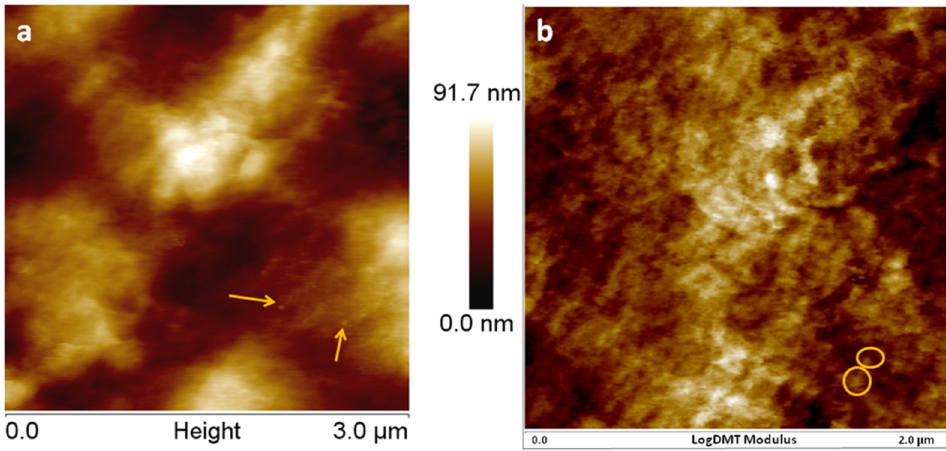
Figure 7. AFM topographic ( a ) and logarithmic modulus ( b ) images of E5.